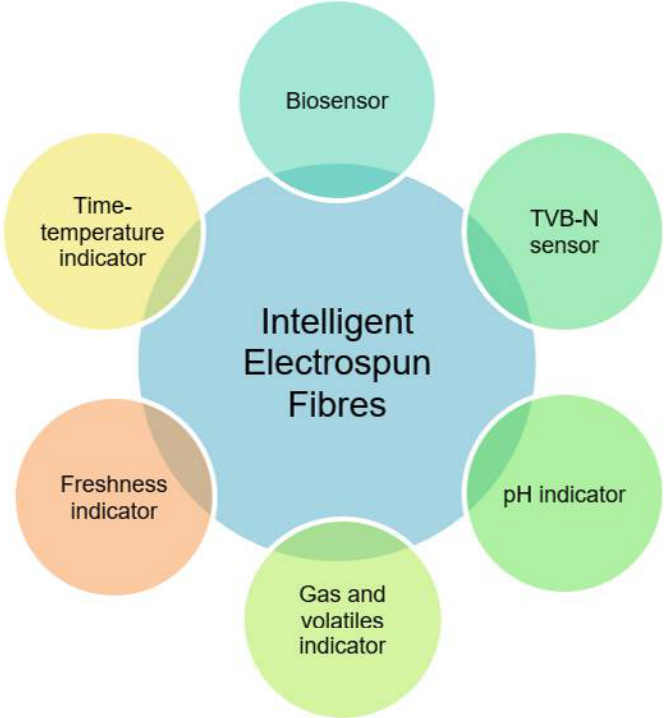
Figure 5. Main indicators of intelligent electrospun fibres for the preservation and processing of meat and